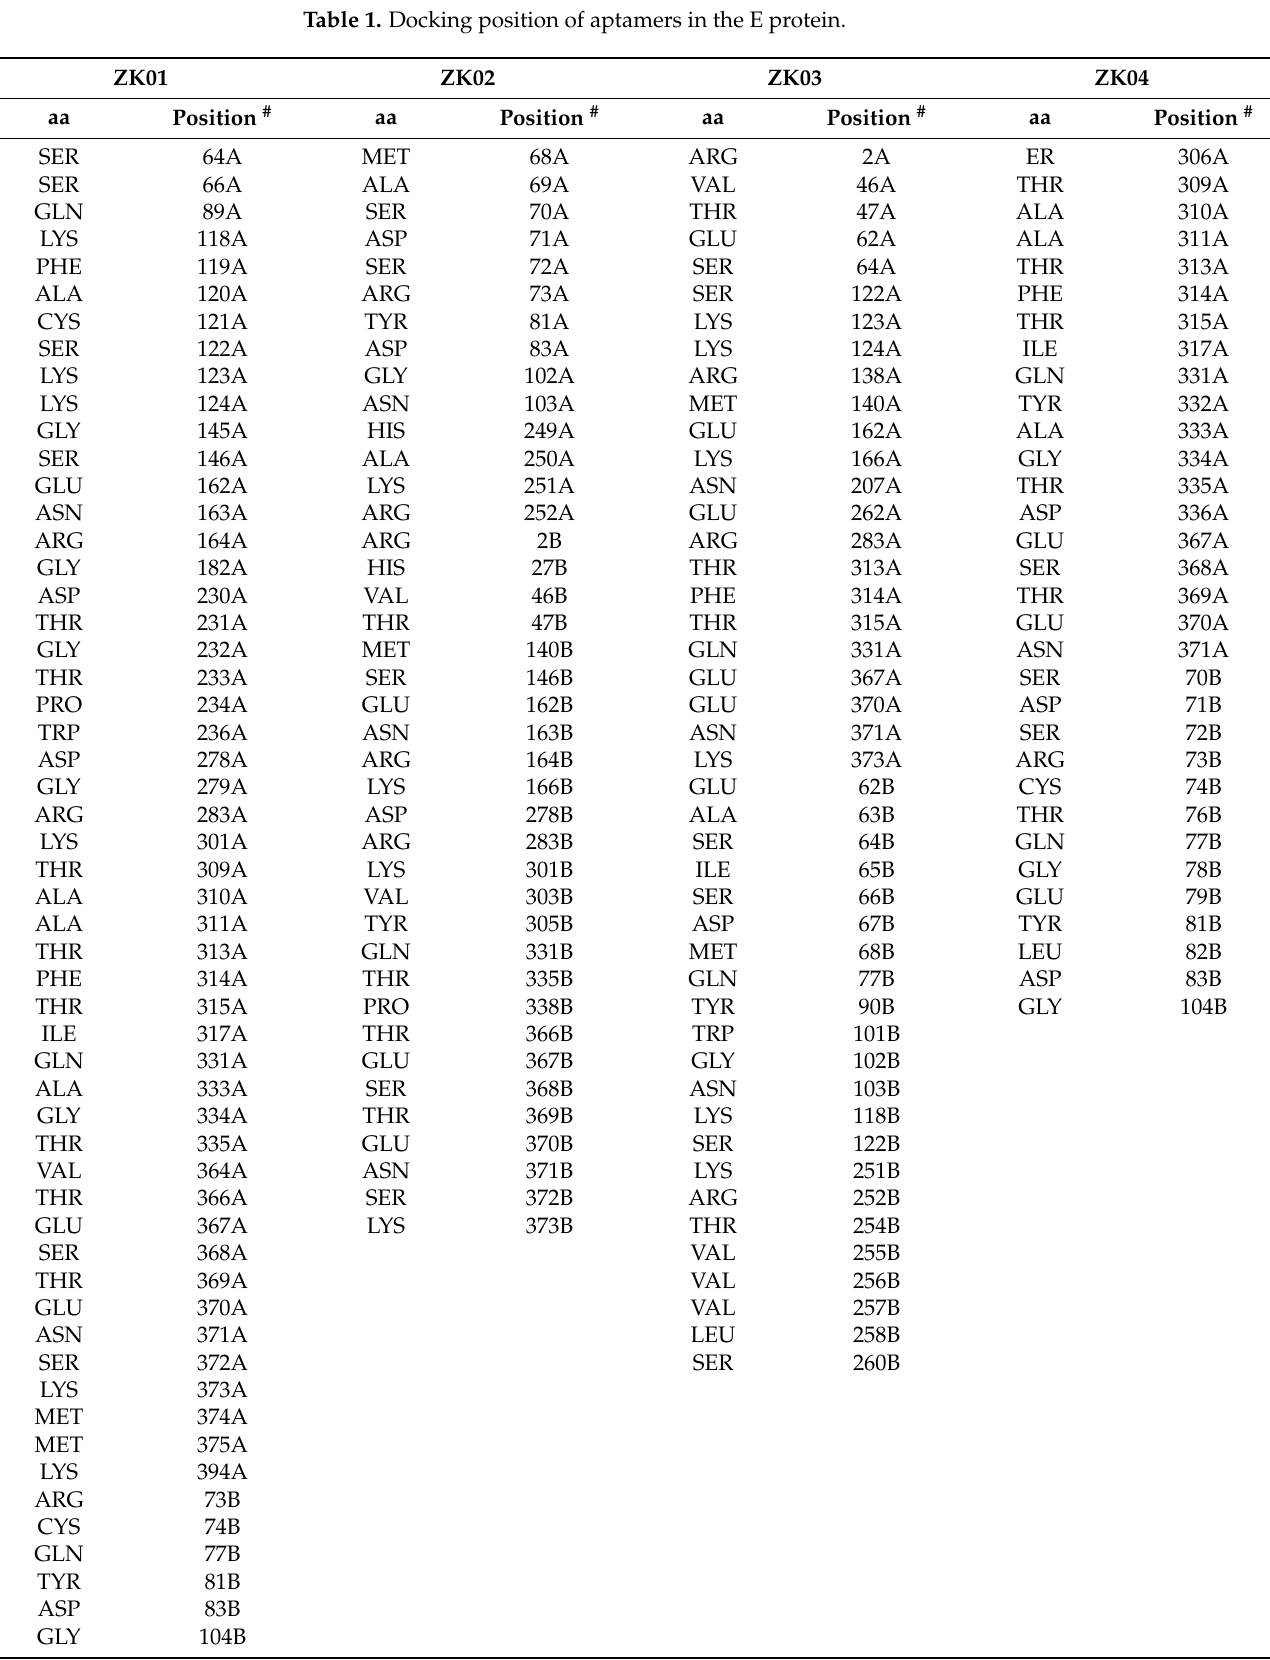
Table 1. Docking position of aptamers in the E